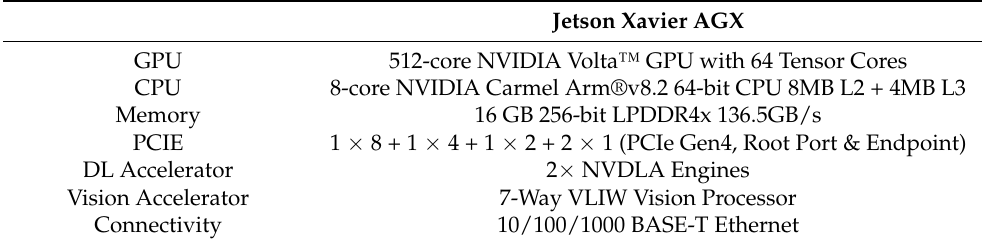
Figure 5. Qu3D scenario for GPU parallel processing based on NVIDIA Volta architecture as provided by an NVIDIA Jetson AGX Xavier device. Table 1. NVIDIA Jetson Xavier AGX: Technical